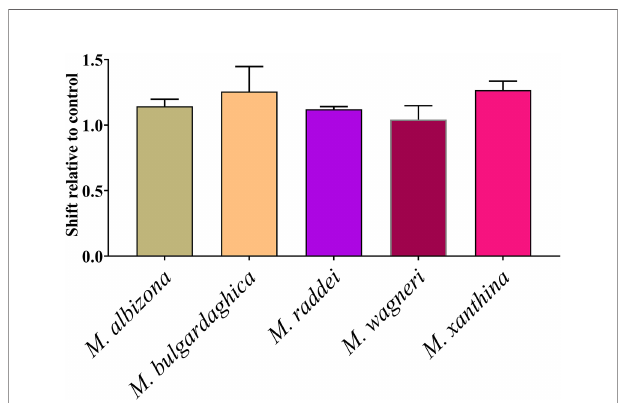
FIGURE 9 | Shift of clotting time relative to control due to inhibition of Factor Xa (no effect relative to control would be a value of 0). Data points are N = 3 mean